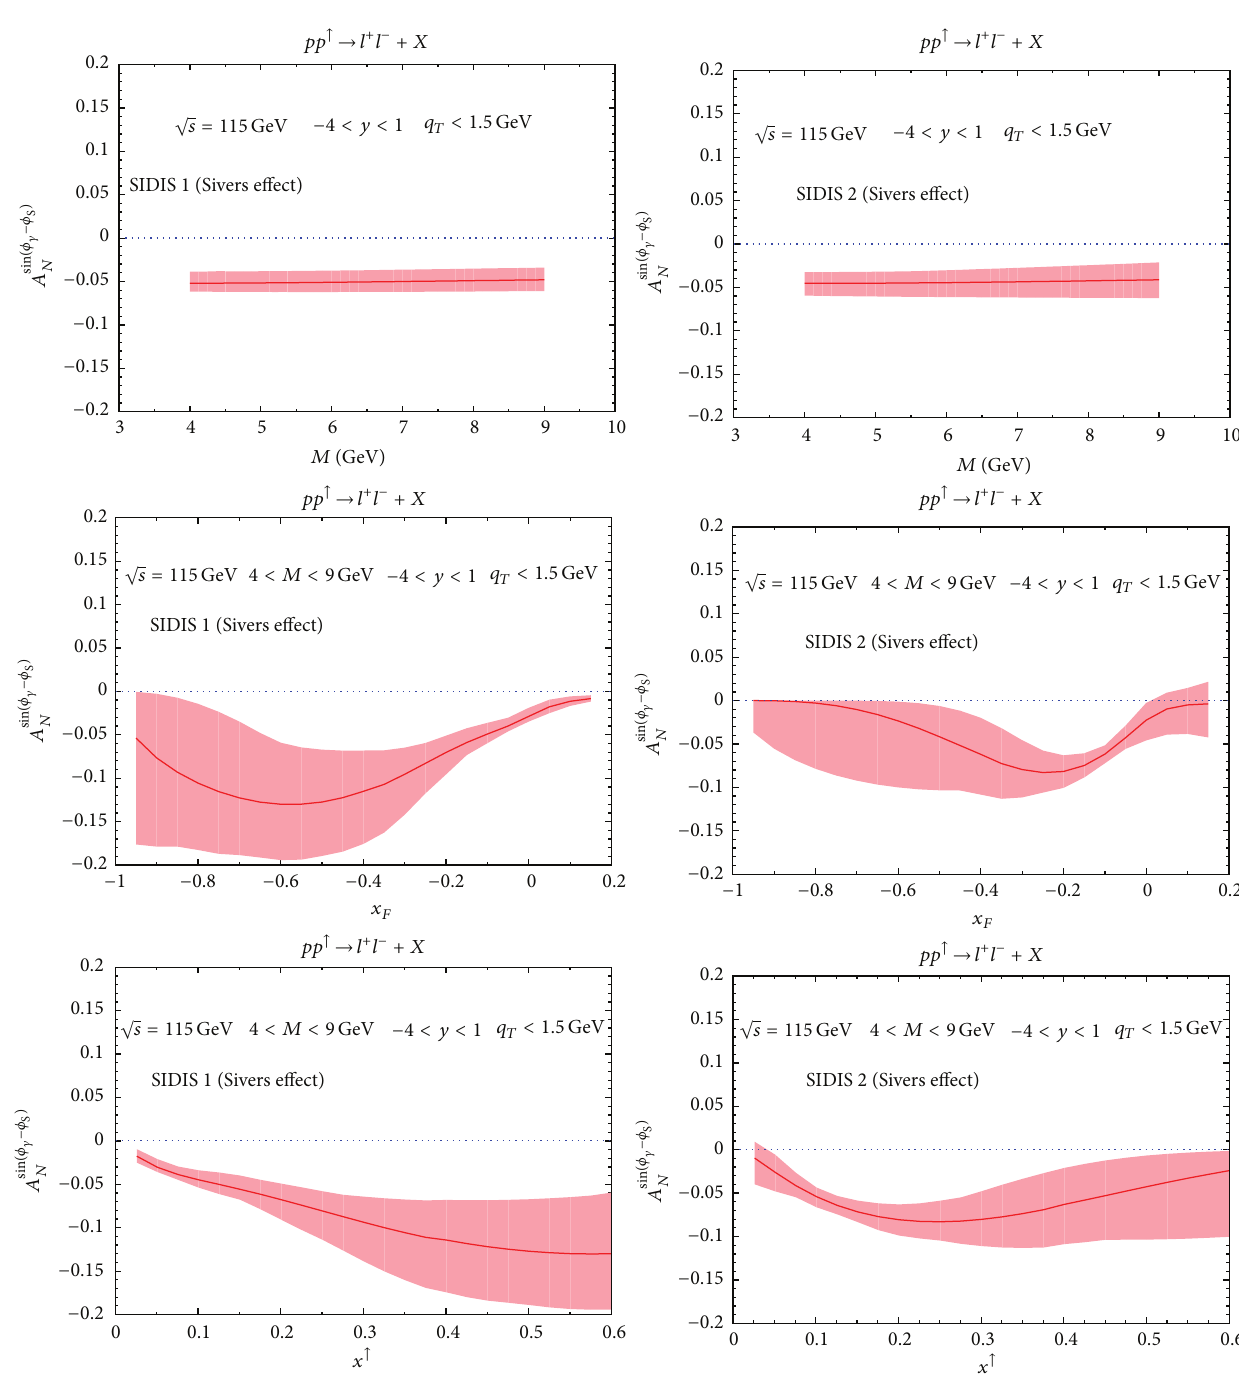
(𝜙 𝛾 −𝜙 𝑆 ) Figure 10: Our theoretical estimates for 𝐴 𝑁 in D-Y processes as expected at AFTER@LHC. Our results are presented as function of (upper plots), 𝑥 𝐹 (middle plots), and 𝑥 of the quark inside the polarised proton, 𝑥 ↑ (lower plots). The other kinematical variables are either fixed or integrated, as indicated in each figure. They are computed according to [35] and (21), adopting the Sivers functions of [20] (SIDIS 1, left panels) and of [21] (SIDIS 2, right panels), reversed in sign . The overall statistical uncertainty band, also shown, is obtained following the procedure described in Appendix A of